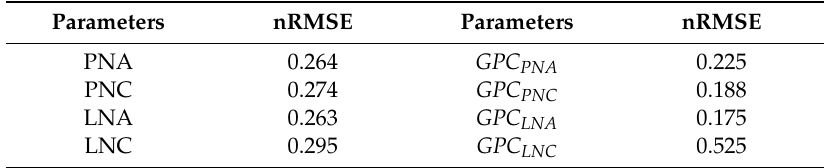
Table 10. nRMSE of the four nitrogen nutrition parameters and wheat grain protein inversion results based on the 2003–2006